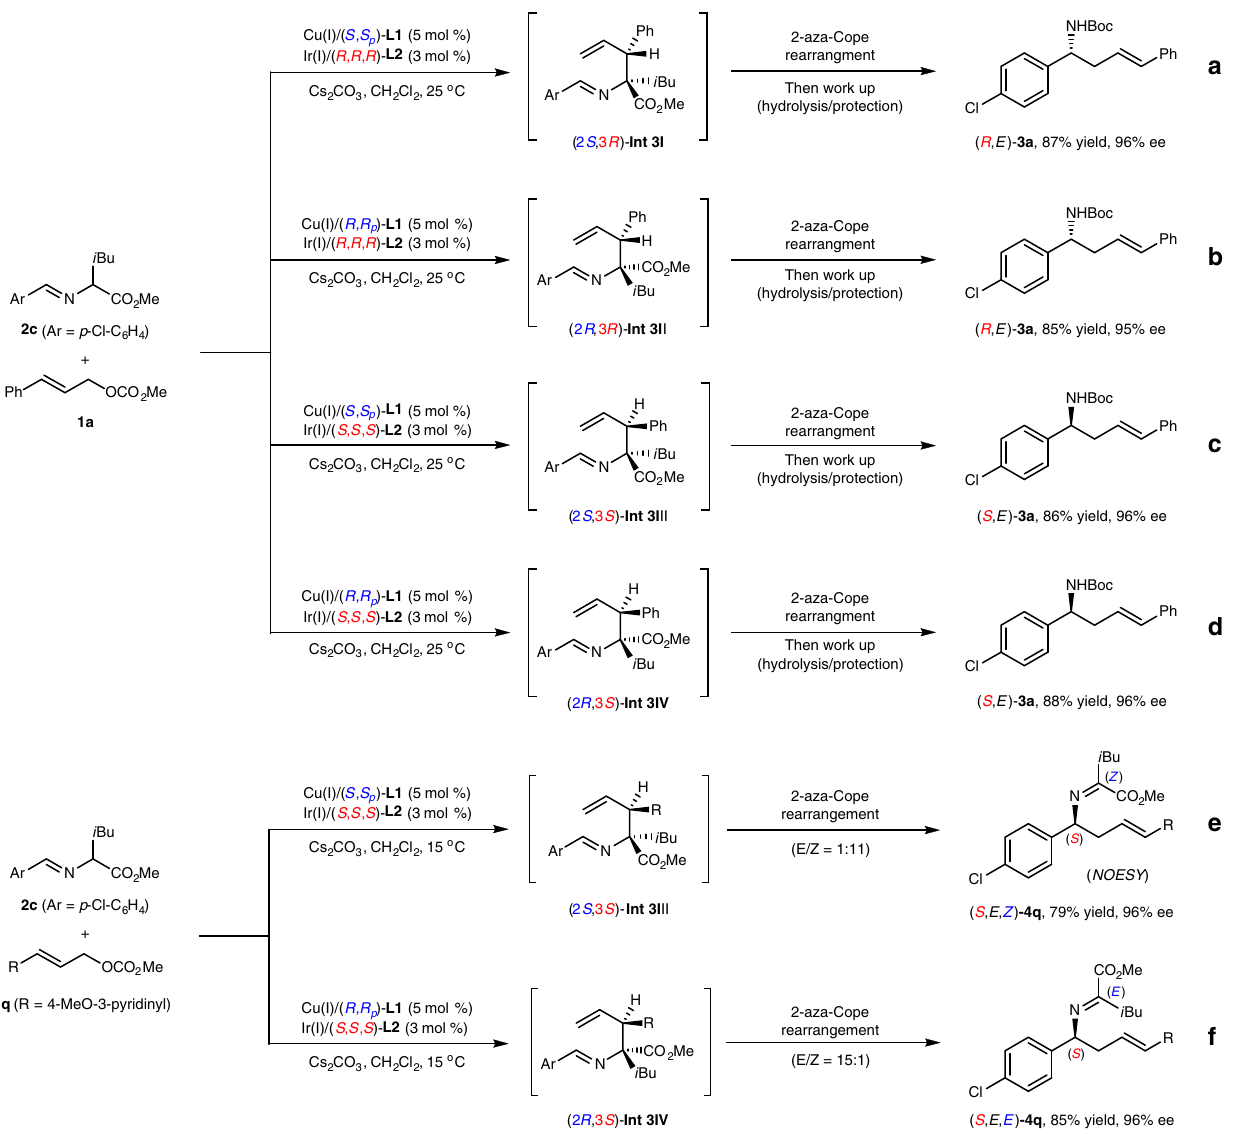
Fig. 3 Parallel experiments with different set of catalyst combinations. a – d Study on the chirality transfer. e – f Study on the geometry of the generated imine